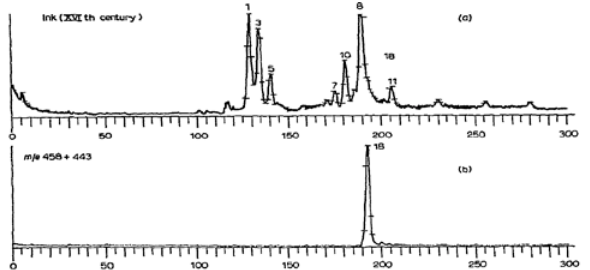
Figure 12. One of the first on-line GC-MS for binding media analy- sis: computer reconstructed plots of (a) TIC of a 16 th century ink hydrolysate; (b) mass chromatogram at m/e 458 plus 443 specific for gallic acid (all analytes as TMS derivatives). Packed column, T -program; MS scan speed 1 set/decade in cyclic mode, period 4 s. Peak numbering: peaks 1, 3, 5, 7, 8: furanose and pyranose epimers of arabinose and galactose, resp.; peaks 10 and 11, α- and β-glucopyranose, resp.; peak 18, gallic acid. For details see Supple- mentary Information and ref. [101] . From ref. [101] with permission.